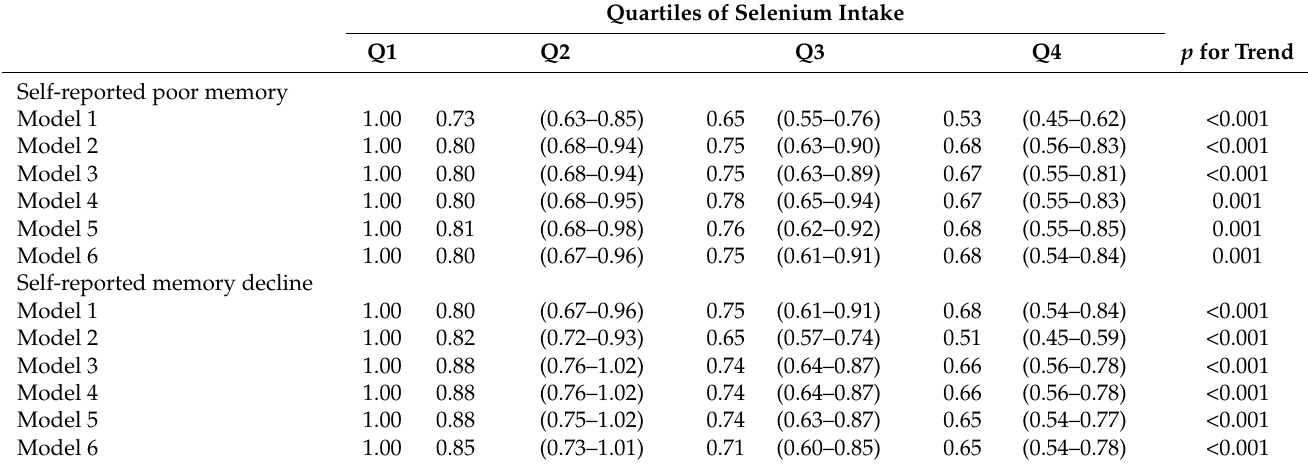
Table 3. Odds ratios (95% CI) for self-reported poor memory and self-reported memory decline by quartiles of selenium intake among Chinese adults aged ≥ 55 years in the China Health and Nutrition Survey ( n = 4852).